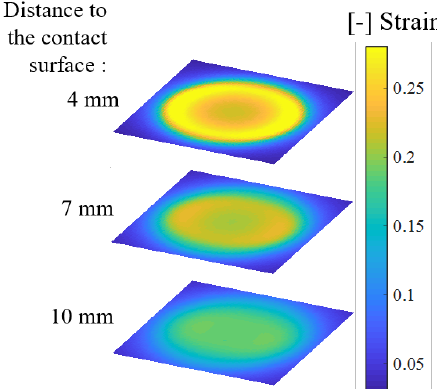
Figure 8. Simulated shear strain distribution under uni-directional shear tractions on circular regions in the stress